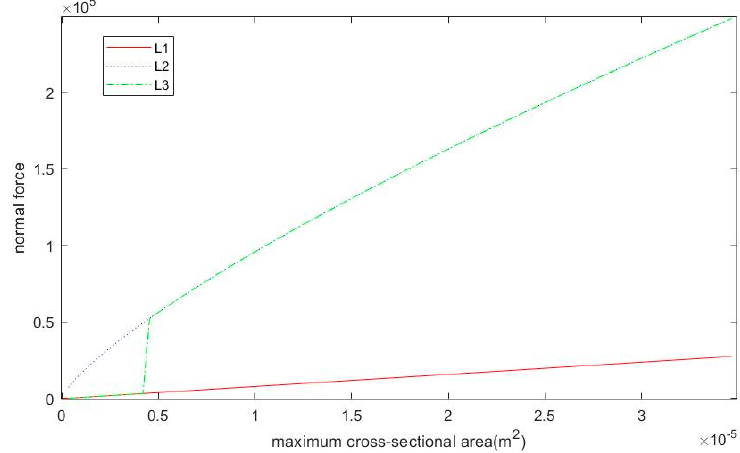
Figure 2. Plot of normal force versus maximum cross-sectional